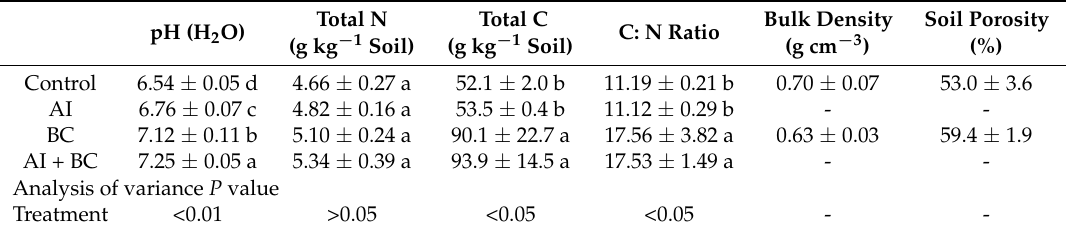
Table 2. Effect of aerated irrigation (AI) and/or biochar (BC) on properties of soil after harvest of Komatsuna. Values are mean ± standard deviation ( n = 3). Means followed by the same letters are not significantly different at the P ≤ 5% level by the LSD